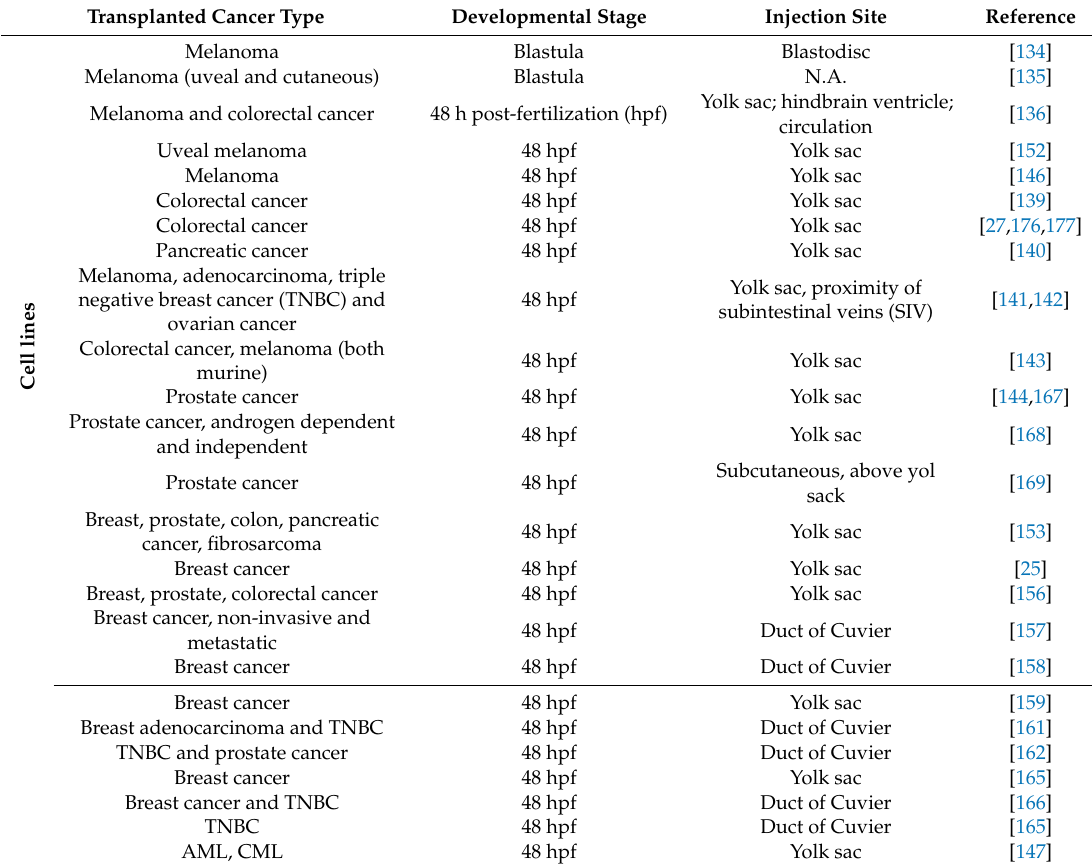
Table 4. Human cancer xenograft transplantation models in